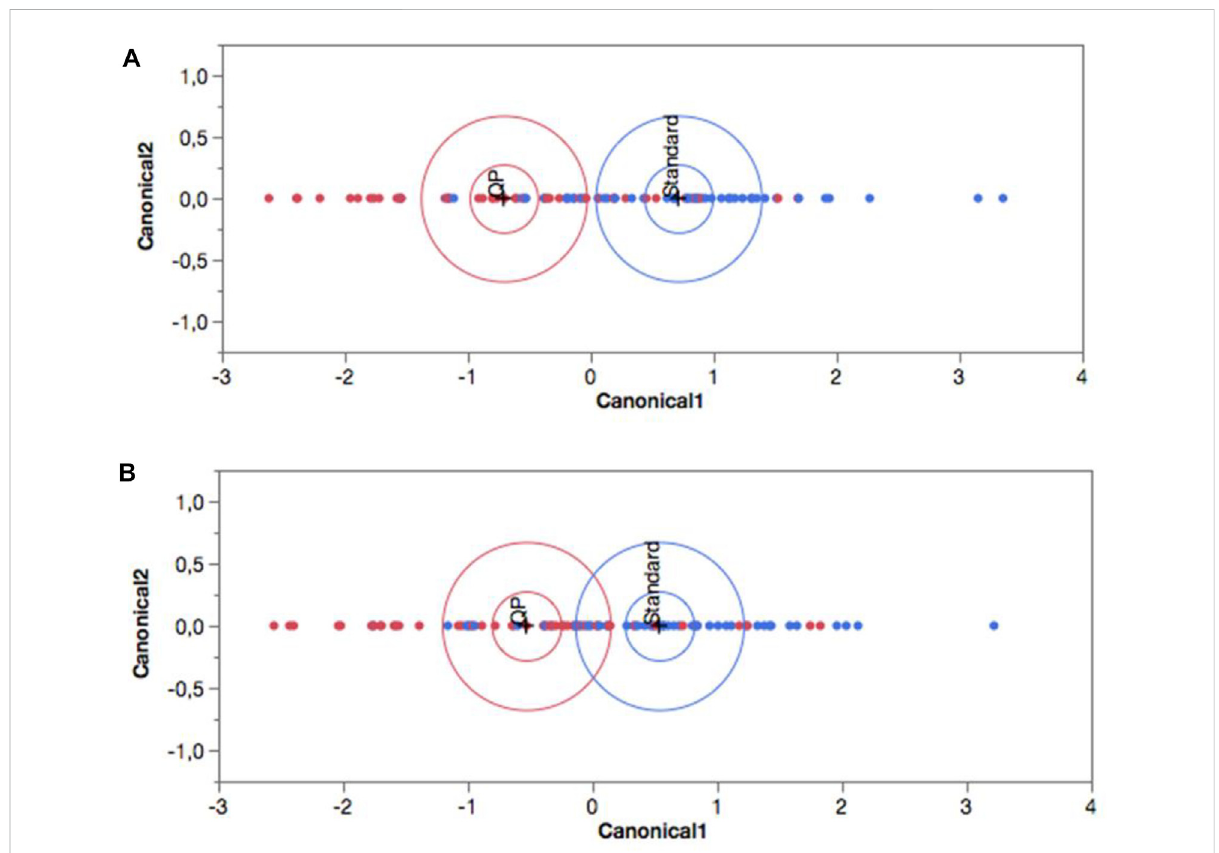
FIGURE 5 CanonicalplotofthetwotreatmentgroupsobtainedbyDiscriminantAnalysisat (A) baselineand (B) Day7.Blue(standardofcarealone),andred (with Quercetin Phytosome ® ) colours represents control and quercetin group respectively. The observations and the multivariate means of each group are represented as points on the biplot and expressed in terms of the fi rst two canonical variables. The point corresponding to each multivariatemeanisdenotedbyaplus( ” + “ )marker.A95%con fi dencelevelellipseisplottedforeachmean.Iftwogroupsdiffersigni fi cantly,the con fi dence ellipses tend not to intersect. An ellipse denoting a 50% contour is plotted for each group. This depicts a region in the space of the fi rst two canonical variables that contains approximately 50% of the observations, assuming